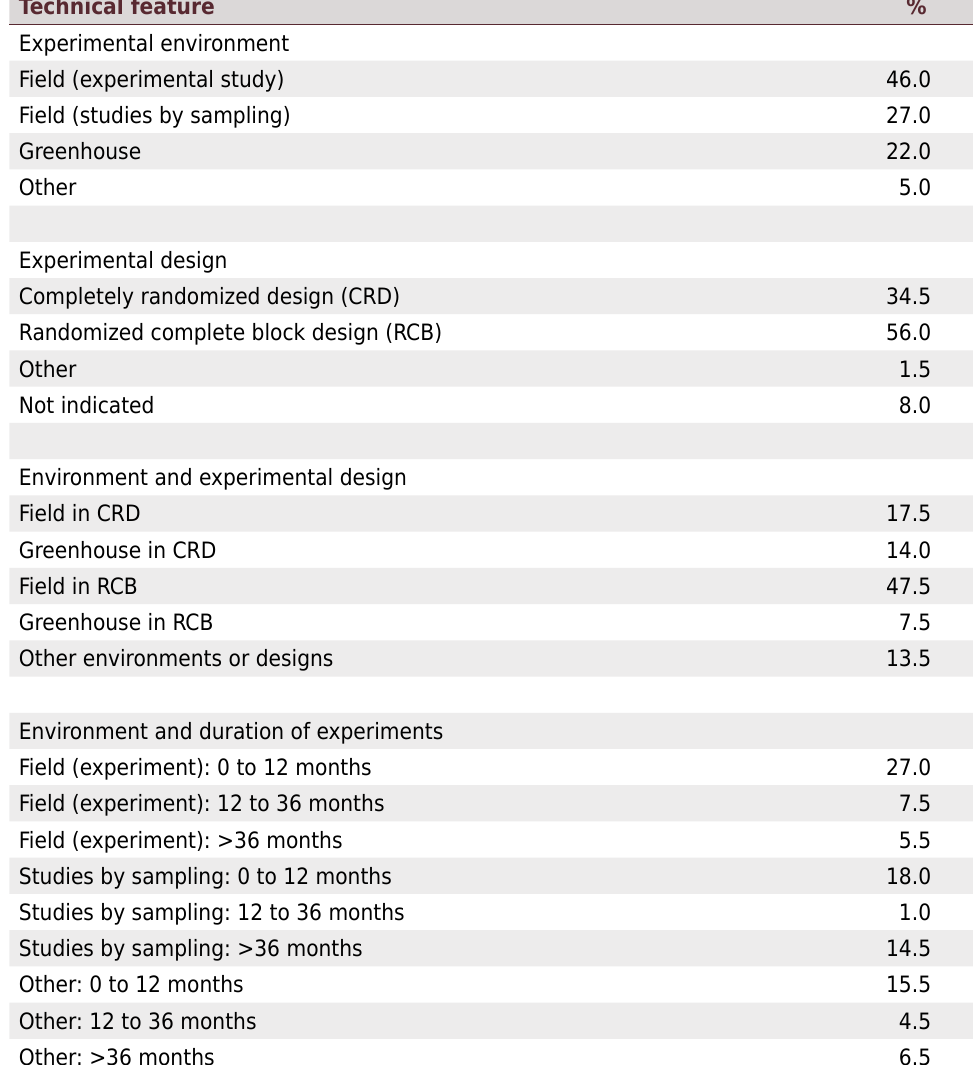
Table 1. Frequency of studies, in percentages of the total number of studies assessed, classified according to the characteristics of the experiments in soil science in Brazilian journals in relation to the environment and experimental design Technical